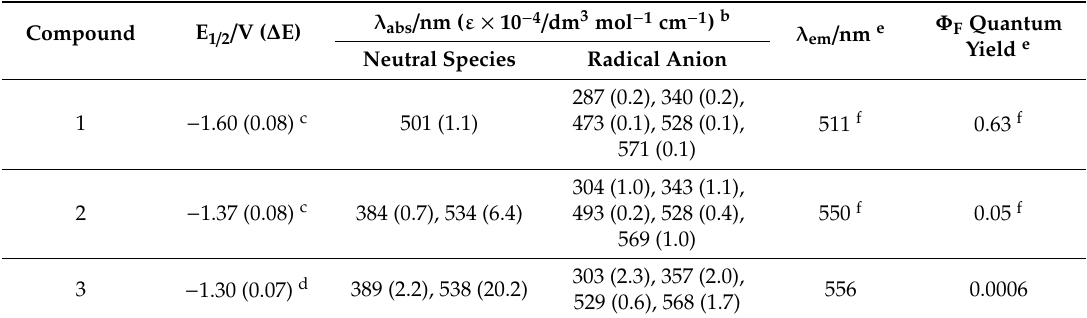
The optical properties of 2 and 3 give UV-visible spectral profiles characteristic of BODIPY compounds (Table 1) with bands corresponding to the (S 0 → S 1 , π - π *) transition of the dipyrrin ligands. The band maxima of 2 and 3 in CH 2 Cl 2 were observed at 534 and 539 nm, respectively, showing that iodination at the 2- and 6-positions of the dipyrrin results in bathochromic shifts of approximately 30 nm in the absorption maximum of 2 in comparison with 1 and a 19 nm bathochromic shift in comparison to the previously reported mono-iodinated derivatives [32]. The morpholino substituted Table 1. Summary of cyclic voltammetry data, absorption wavelengths (λ ) and extinction species, 3 , displays intense absorptions of approximately three times the intensity of those observed abs for 2 , which also show a further small bathochromic shift. This results in substantial colour changes for coefficients (ε) for neutral and reduced species and emission data for compounds 1–3. a solutions of the three compounds (Figure 3). It is also noticeable that for 3, fluorescence is essentially quenched with very low quantum yield, Φ F = 0.0006 in CH 2 Cl 2 in comparison to values of 0.63 [33] or 0.05 [33] for 1 and 2, respectively. This quenching can be attributed to the presence of the tertiary amine of the morpholino-substituent. Table 1. Summary of cyclic voltammetry data, absorption wavelengths ( λ abs ) and extinction coe ffi cients ( ε ) for neutral and reduced species and emission data for compounds 1–3. a Compound